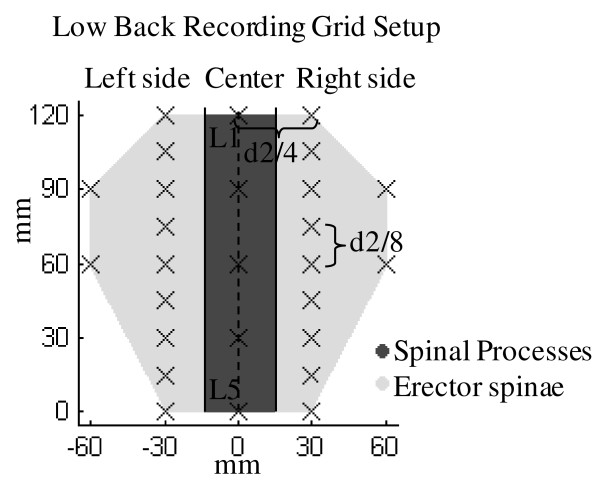
Schematic representation of the low back PPT recording grid (27 points). All distances between adjacent points were based on an anthropometric measure (the distance (d2) between the first (L1) and fifth (L5) lumbar vertebrae). The lumbar region was divided by location (left side, center and right side).